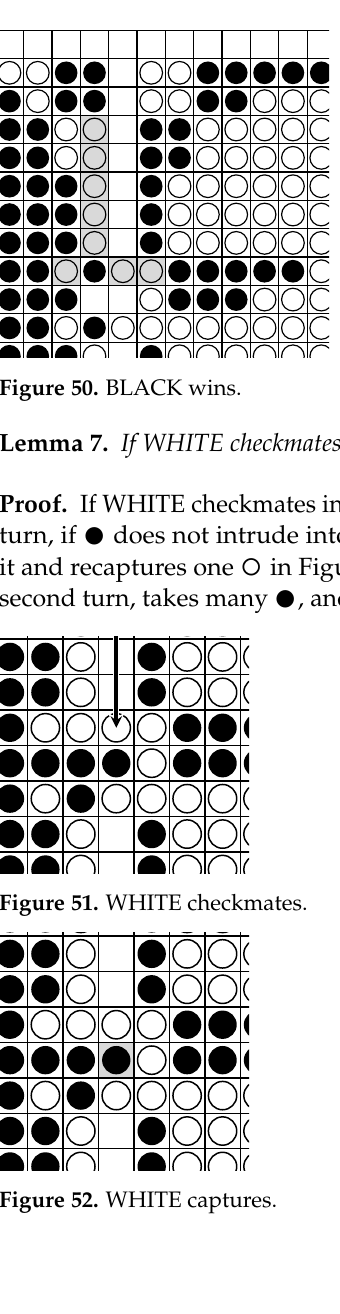
Figure 49. BLACK comes in.